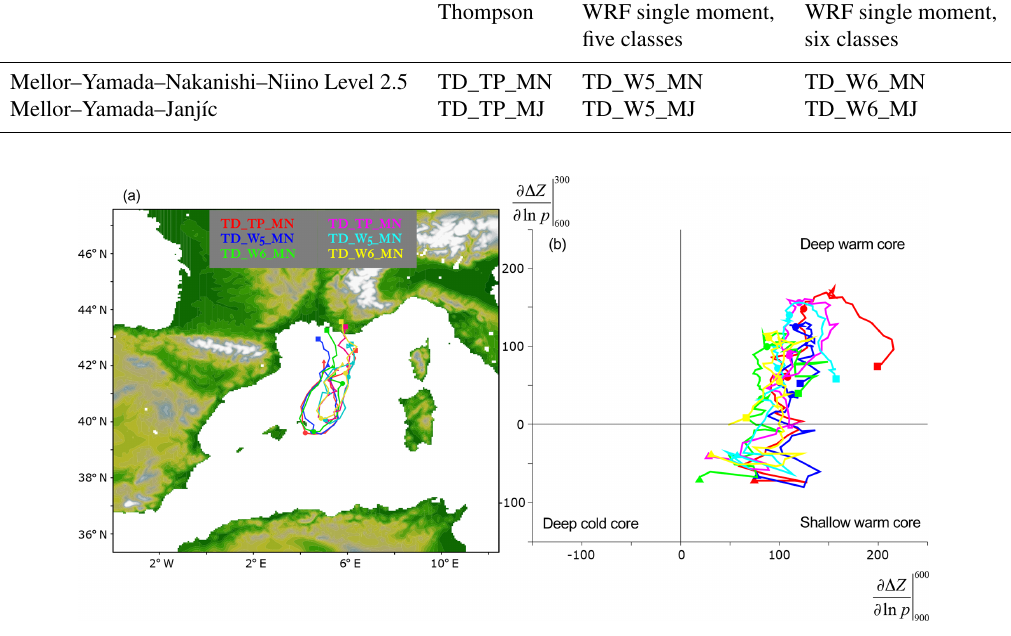
Figure 3. (a) Trajectory of six ensembles of medicane Rolf PRS, from 00:00UTC, 6 November 2011 to 00:00UTC, 9 November. The tracking is based on the lowest sea level pressure. The colours of red, blue, green, magenta, light blue, and yellow are for